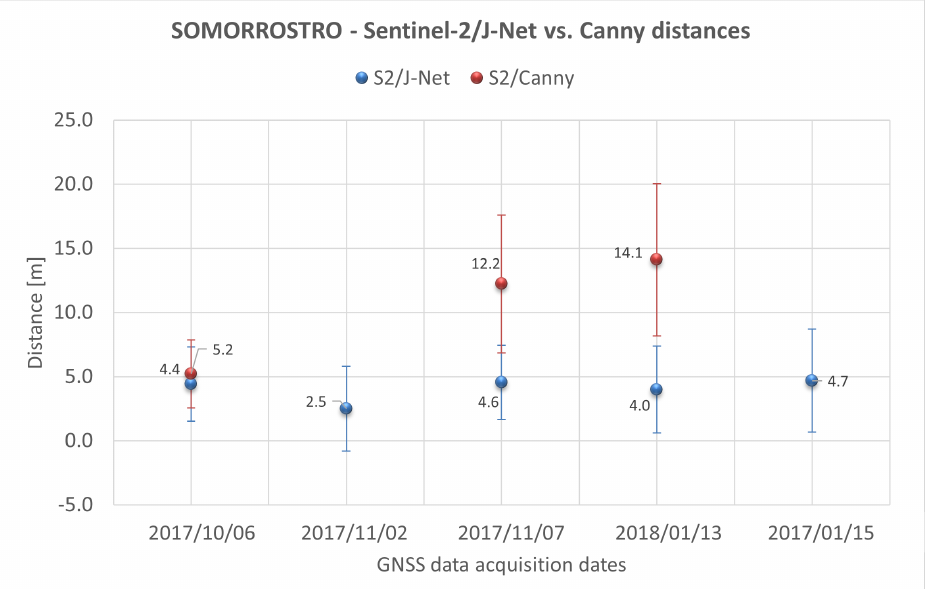
Figure A2. Comparison between the mean distance and standard deviation for each date on Sentinel-1 imagery considering J-Net Dynamic and Canny algorithms in Castelldefels.